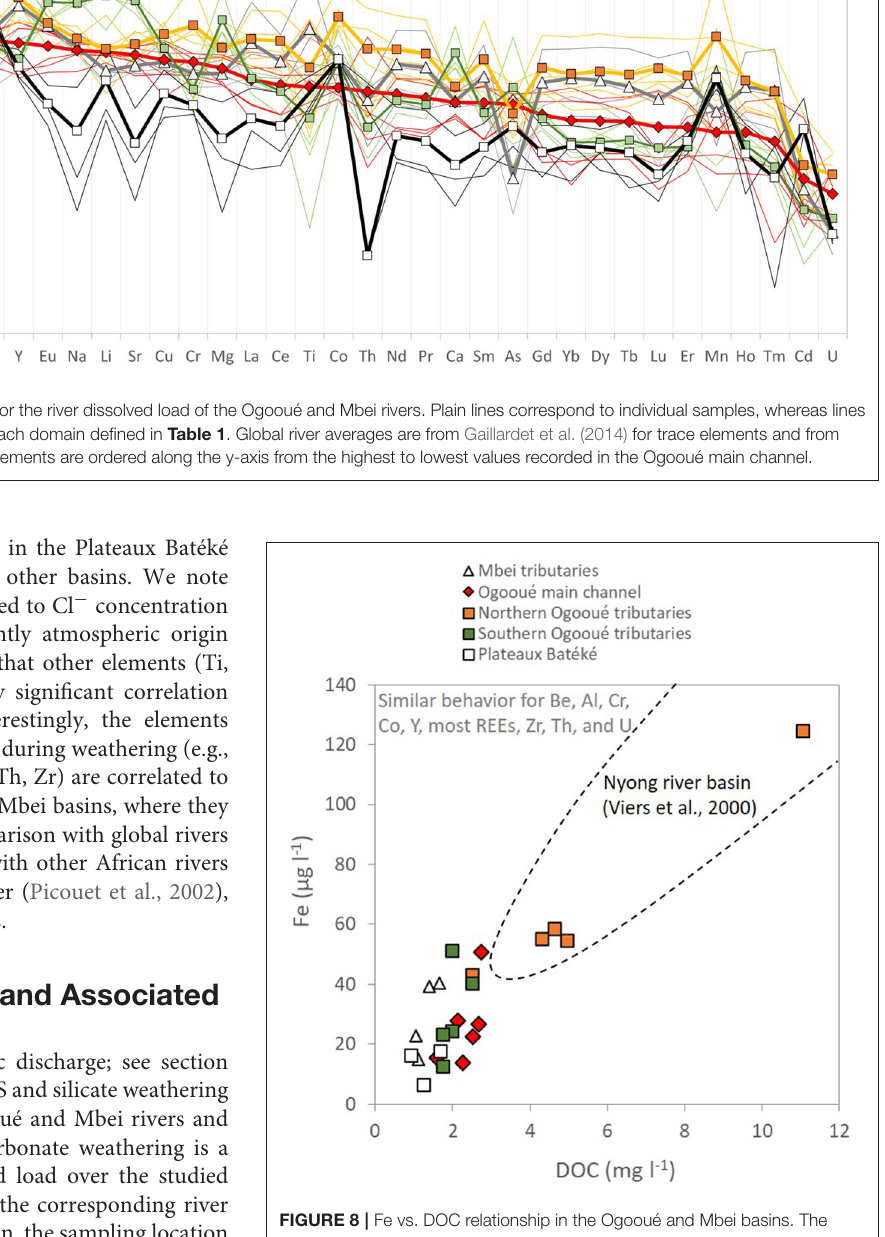
FIGURE 8 | Fe vs. DOC relationship in the Ogooué and Mbei basins. The domain corresponding to the Nyong values (monthly sampling from